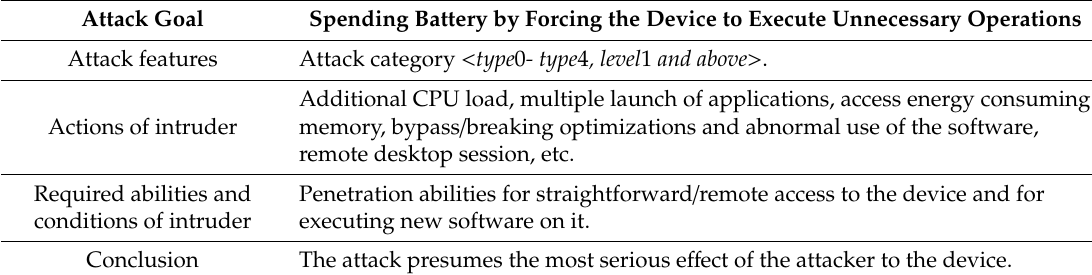
Table 4. Misuse of a device’s